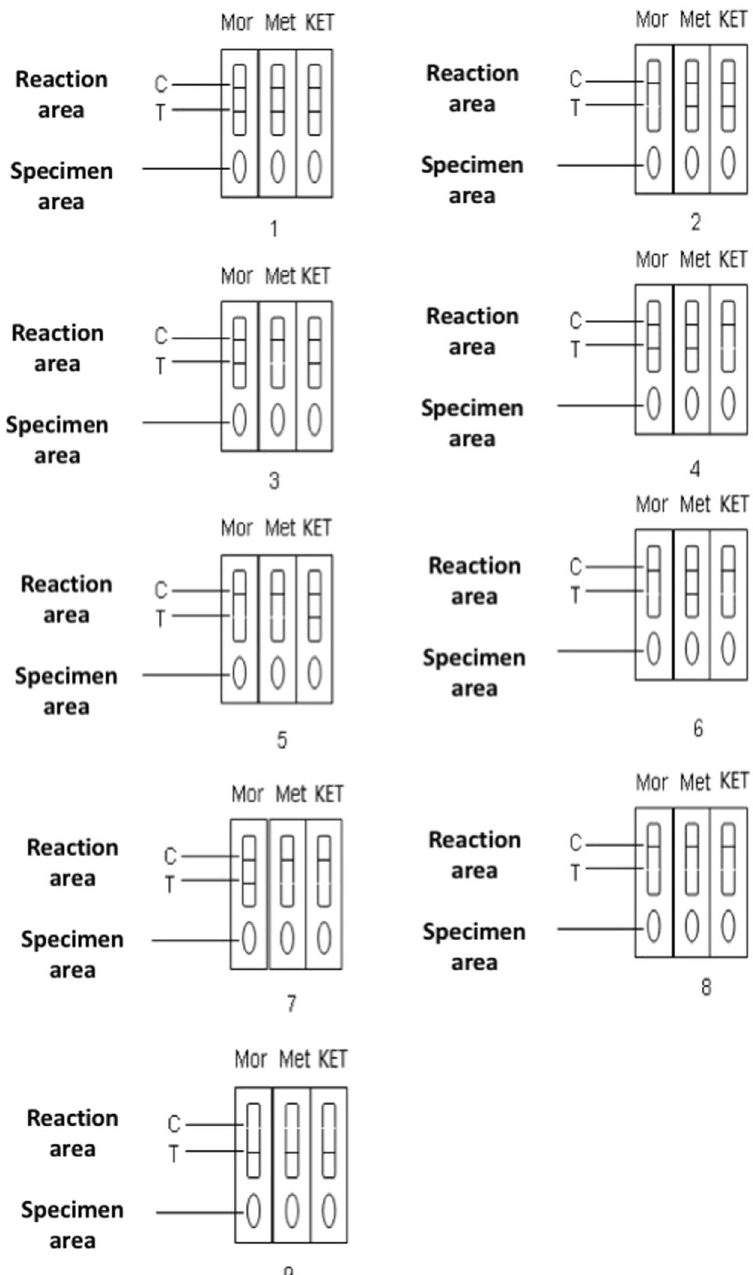
Figure 2. Interpretation of the Morphine & Methamphetamine & Ketamine Diagnostic Kit. (1) Positivity: There is only one red control line (C) in the reaction area. (2) Negativity: There are a red control line (C) and test lines (T) in the reaction area. (3) Invalid: There is no control line (C) in the reaction area, no matter whether there is a test line (T) or not; in this case, retesting with a new cassette device is